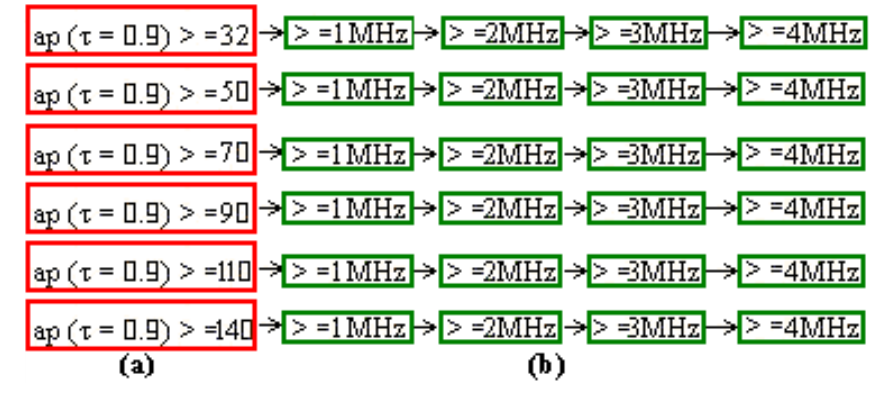
Fig. 5. Scheme followed to select data relative to different disturbed magneto-ionospheric conditions.